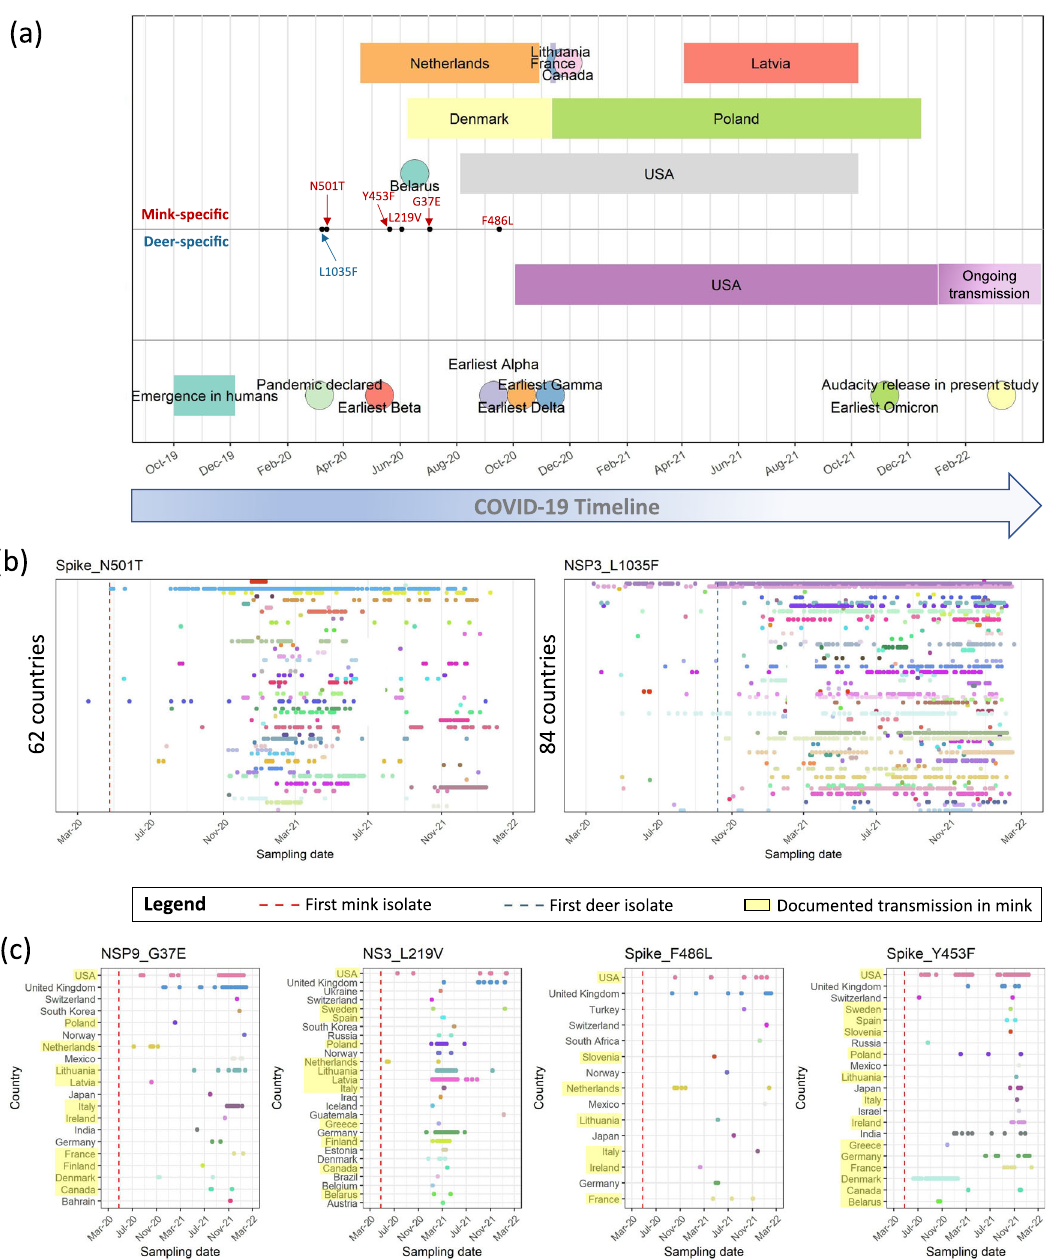
Fig. 3 Timeline of the COVID-19 pandemic. a The key events of the pandemic from the estimated emergence of SARS-CoV-2 in humans 3 to the sampling dates of the fi rst isolates for each VoC are annotated in the lowest panel. The coloured rectangles in the upper fi rst and second panels indicate the range of sampling dates of animal-associated SARS-CoV-2 sequences in the different countries. The sampling dates of the earliest human isolates carrying each candidate mutation are annotated along the timeline are indicated by black points. Panels b and c show the temporal distributions of candidate mutations in human SARS-CoV-2 isolates collected prior to 17th March 2022. Red and blue dashed lines indicate the sampling date of the fi rst mink-associated isolate in the Netherlands and deer-associated isolate in the USA, respectively. For panel b , country names were omitted, and the number of countries where the candidate mutations were found in human isolates are annotated. For panel c , countries where human-to-mink transmission has been documented are highlighted in yellow 41